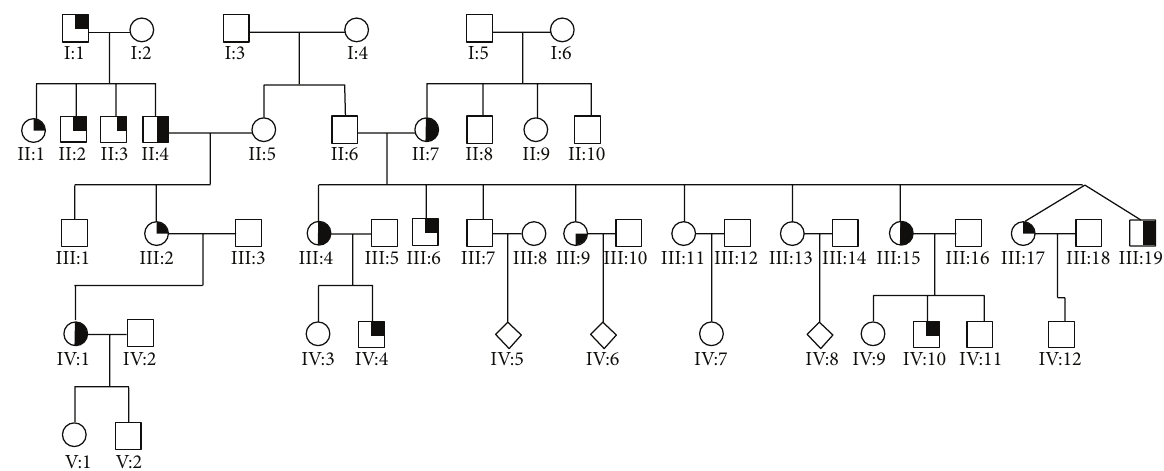
Figure 1: Pedigree of the affected families. Filled upper right quadrant-ataxia; filled lower right quadrant-vision loss/retinal degeneration.